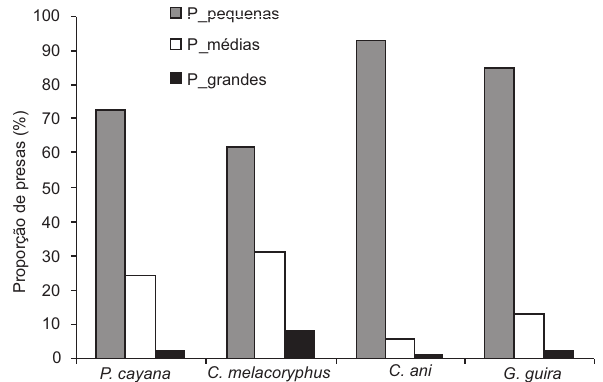
Figura 5. Proporção de presas ingeridas pelas quatro espécies de cuculídeos de acordo com as diferentes classes de